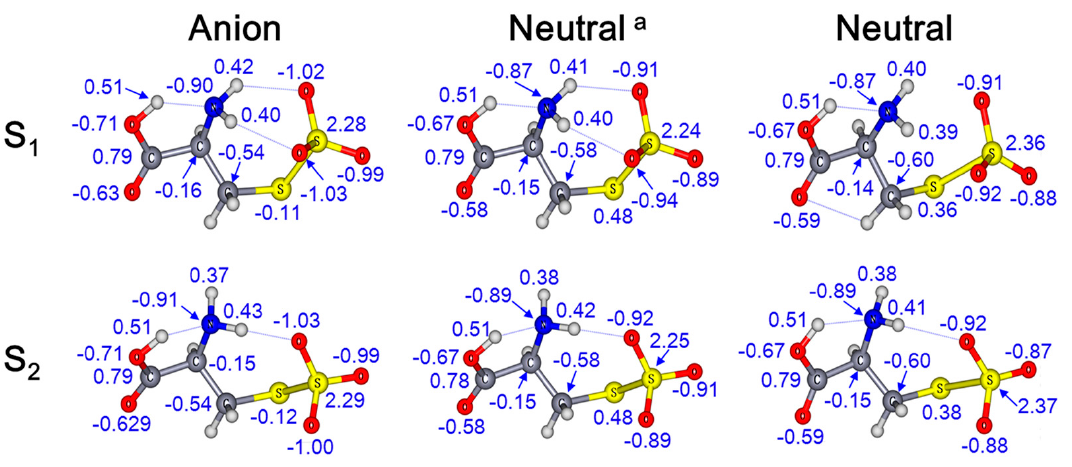
Figure 5. NPA charges on C, N, O, and S atoms and the H atom in hydrogen bonds (blue lines) for the most stable conformers, S 1 and S 2, of [ cysS-SO 3 ] − and their neutral counterparts ( a NPA charges for the neutrals with the anion geometry). Figure6showstheresultsofsuchanalysisforeachHBalongtheO − H · · · · · · N − H · · · · · · O − S chain. A medium donor–acceptor interaction is observed in conformer S 1 with delocalization energy of (cid:52) E(2) = 24.5 kcal/mol between carboxylic O − H and NH 2 , and much weaker, with a delocalization energy of (cid:52) E(2)~1.6–1.9 kcal/mol between NH 2 and SO 3 groups. In the case of S 2